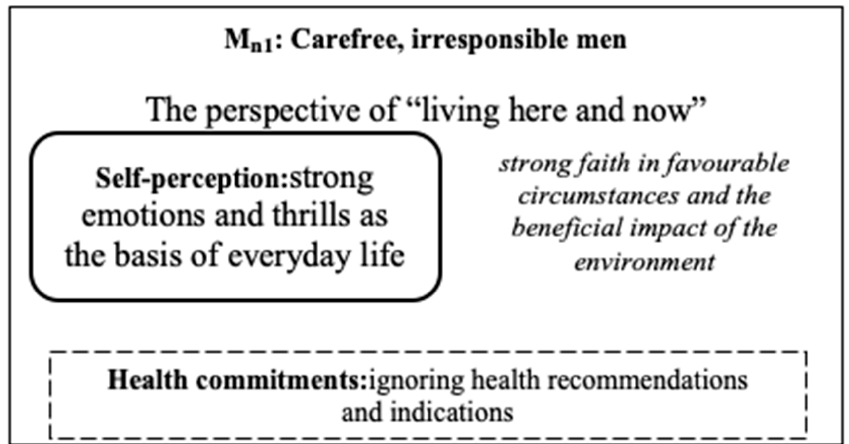
Figure 6. The sub-model: men who are carefree and irresponsible with their